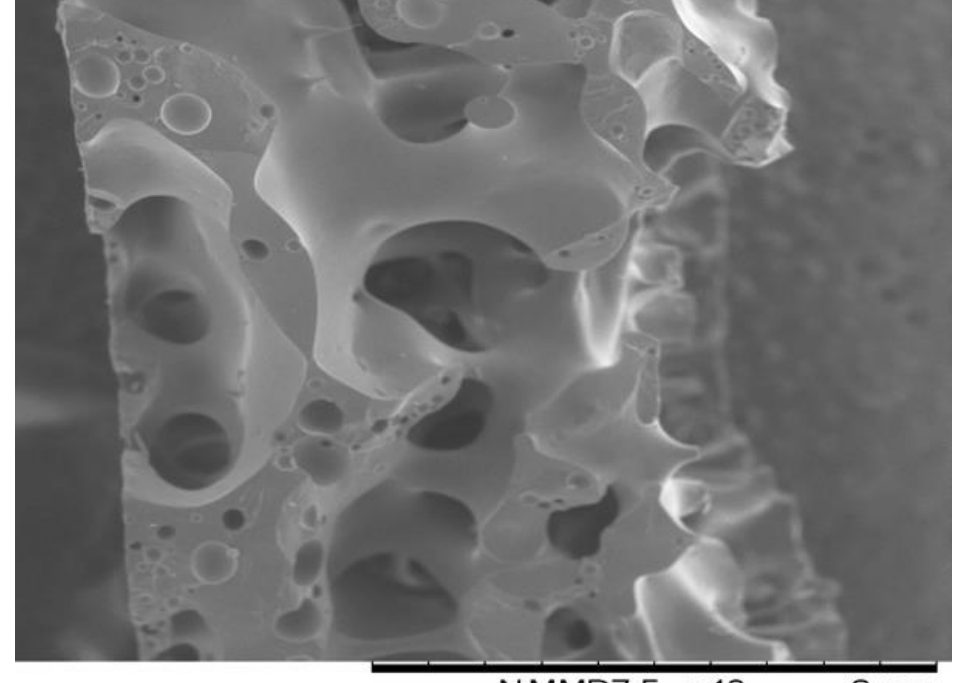
Figure 3. SEM of an open-cell PLA porous